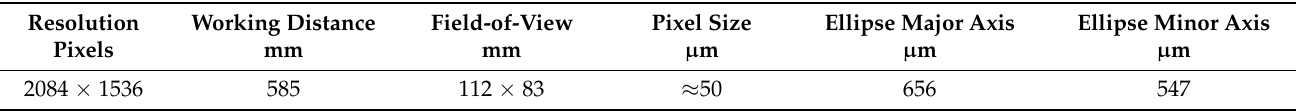
Table 2. Summary of the DIC setup information.